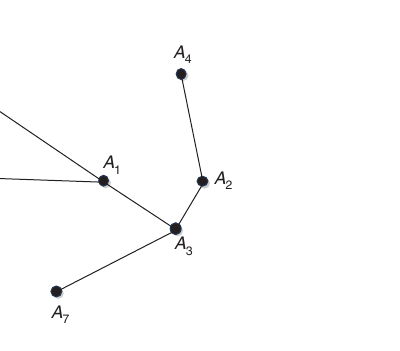
Figure 5. The MST of the Single-Valued Neutrosophic Graph G ( V , E ) with the Eight Nodes.